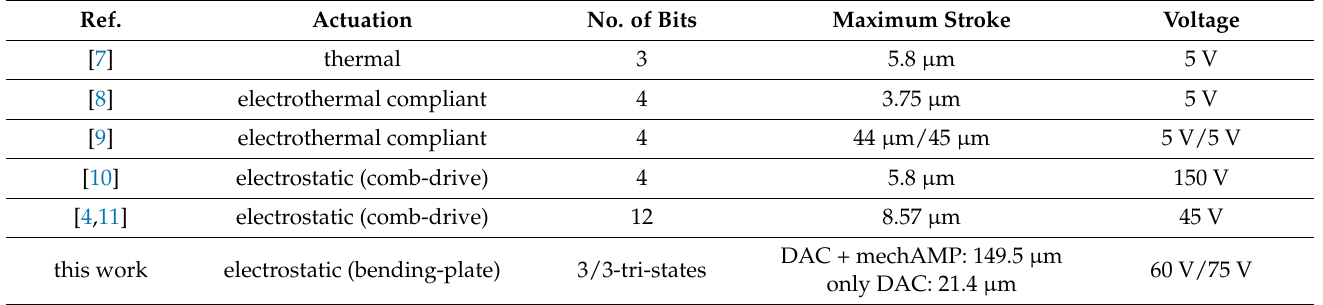
Table 1. Comparison of digital-to-analog converters from the